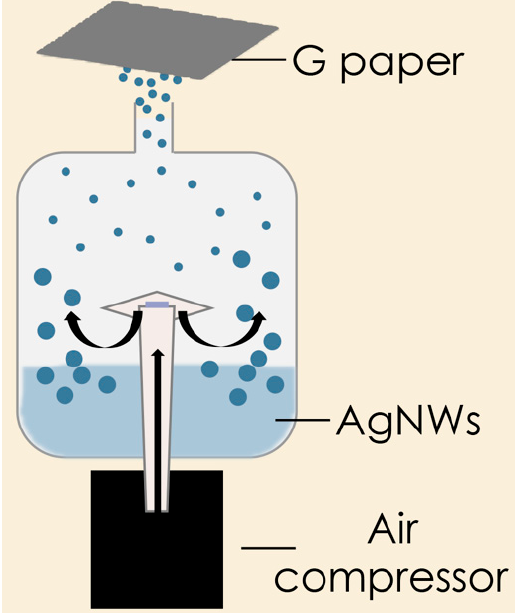
Figure 1. Scheme of aerosol deposition of AgNWs on G-paper. In an attempt to create homogeneous AgNWs films, we varied the deposition time of the original AgNWs batch. A complete and homogeneous coating of the graphene support was obtained after 10 min of aerosol deposition (longer times did not further improve AgNWs coverage of the underlying graphene layer), while lower time values resulted in an uneven distribution (Figure 2a–c). Once we fixed the deposition time to 10 min, we varied the density of deposited AgNWs by sequential dilutions of the particle dispersion. In this case, a 10 mm-wide array of 1.5 mm in size silver spots was obtained by introducing a patterned mask consisting of a thin PET layer placed on the top of the G-paper once wetted with ethanol before nebulization, which ensured a temporary and a tight adhesion at the graphene/PET interface, in turn, avoiding possible edge-leakages of the nanoparticle solution. The mask was exactly centered with the graphene support (see the circled area in Figure 2a) to produce array spots at a comparable surface density of AgNWs. After deposition and mask removal, a pattern of regular and homogeneous AgNWs spots appeared well imprinted on the air-dried graphene (Figure 2d). Array spots obtained by 1:2 dilution of the AgNWs batch corresponding to a 0.5 mg/L density resulted to greatly enhance the Raman signal of 1 × 10 − 6 M hemoglobin (Hb) once excited at 532 nm (Figure 2e). We were able to detect the characteristic signals of Hb mainly ascribed to the heme group [36,37] (Table S1) down to 0.2-mg/L AgNWs density. After further dilution of deposited AgNWs, the protein signals progressively lost intensity, becoming undetectable at 0.02 mg/L where the spectrum corresponded to that of the underlying graphene (inset of Figure 2e). The above-optimized fabrication parameters were thus selected to optimally produce spotted AgNWs@G-paper substrates. We point out that the as-fabricated substrates allow to support the analysis of minimal quantities (2 µ L) of biomolecule solution, which were initially dropped onto an array spot. They were then confined by a high contact angle formed with the surrounding hydrophobic graphene barrier (Figure S2) and finally effectively inspected under the Raman microscope once dried (Figure